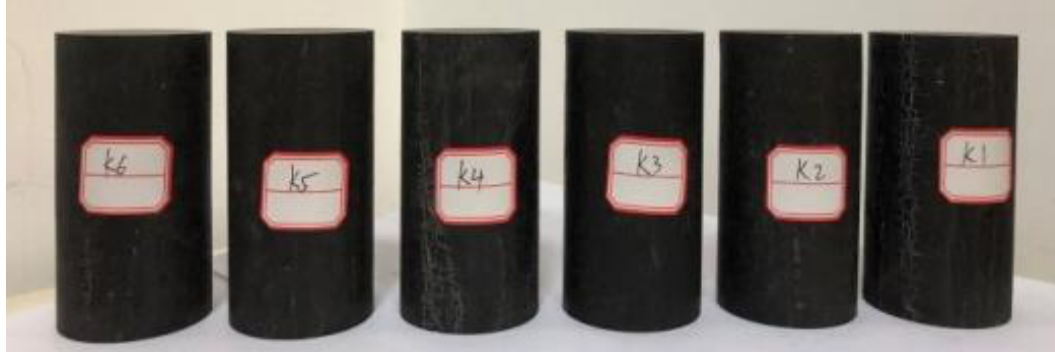
Figure 1. Standard coal specimens.